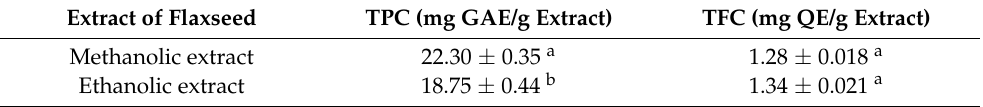
Table 3. Polyphenolic constituents (µg/g) of the ethanolic flaxseed extract determined by HPLC-UV at λ = 280 nm.